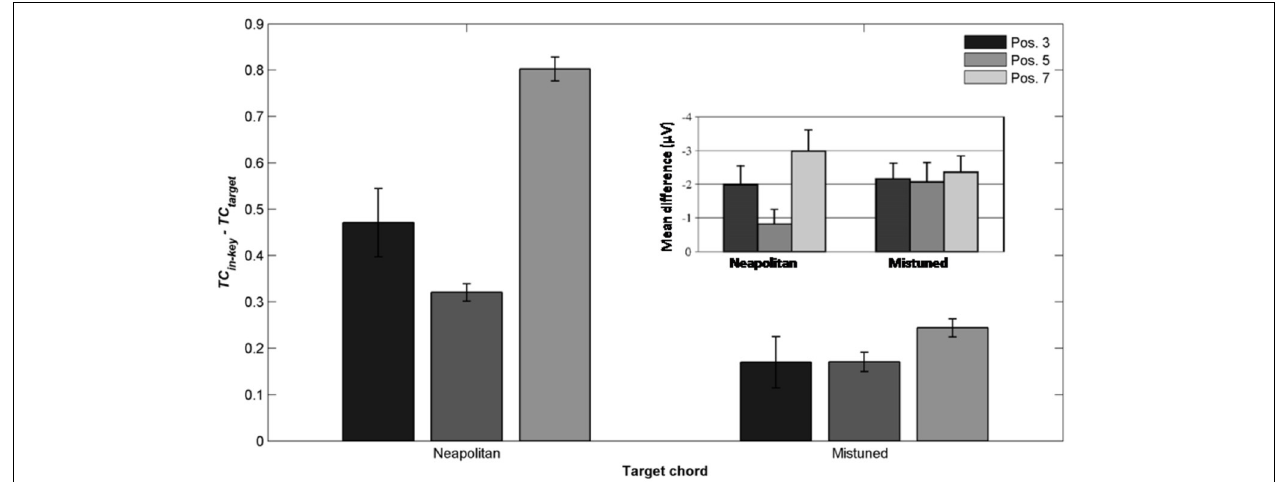
FIGURE 8 | Detailed simulation data obtained with the stimuli of Leino et al. (2007), computed with a local and global context integration windows of 0.1 and 1.5s respectively. Mean TC differences between congruent and incongruent target chords, as a